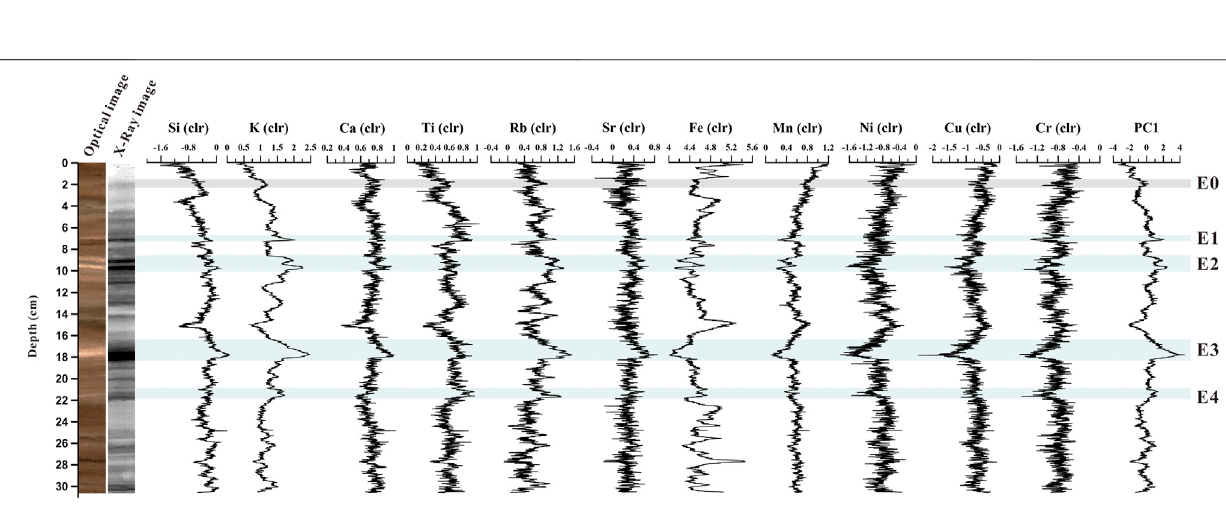
Frontiers in Earth Science |